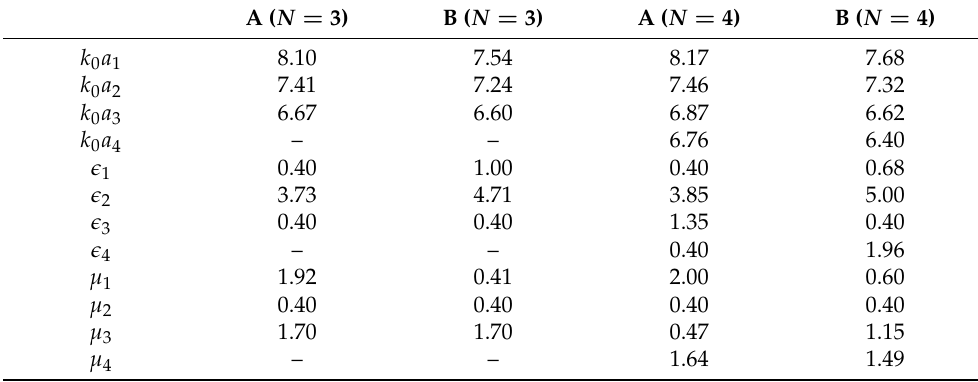
Table A2. Values of the optimization variables for optimized designs A and B of Figure 4.